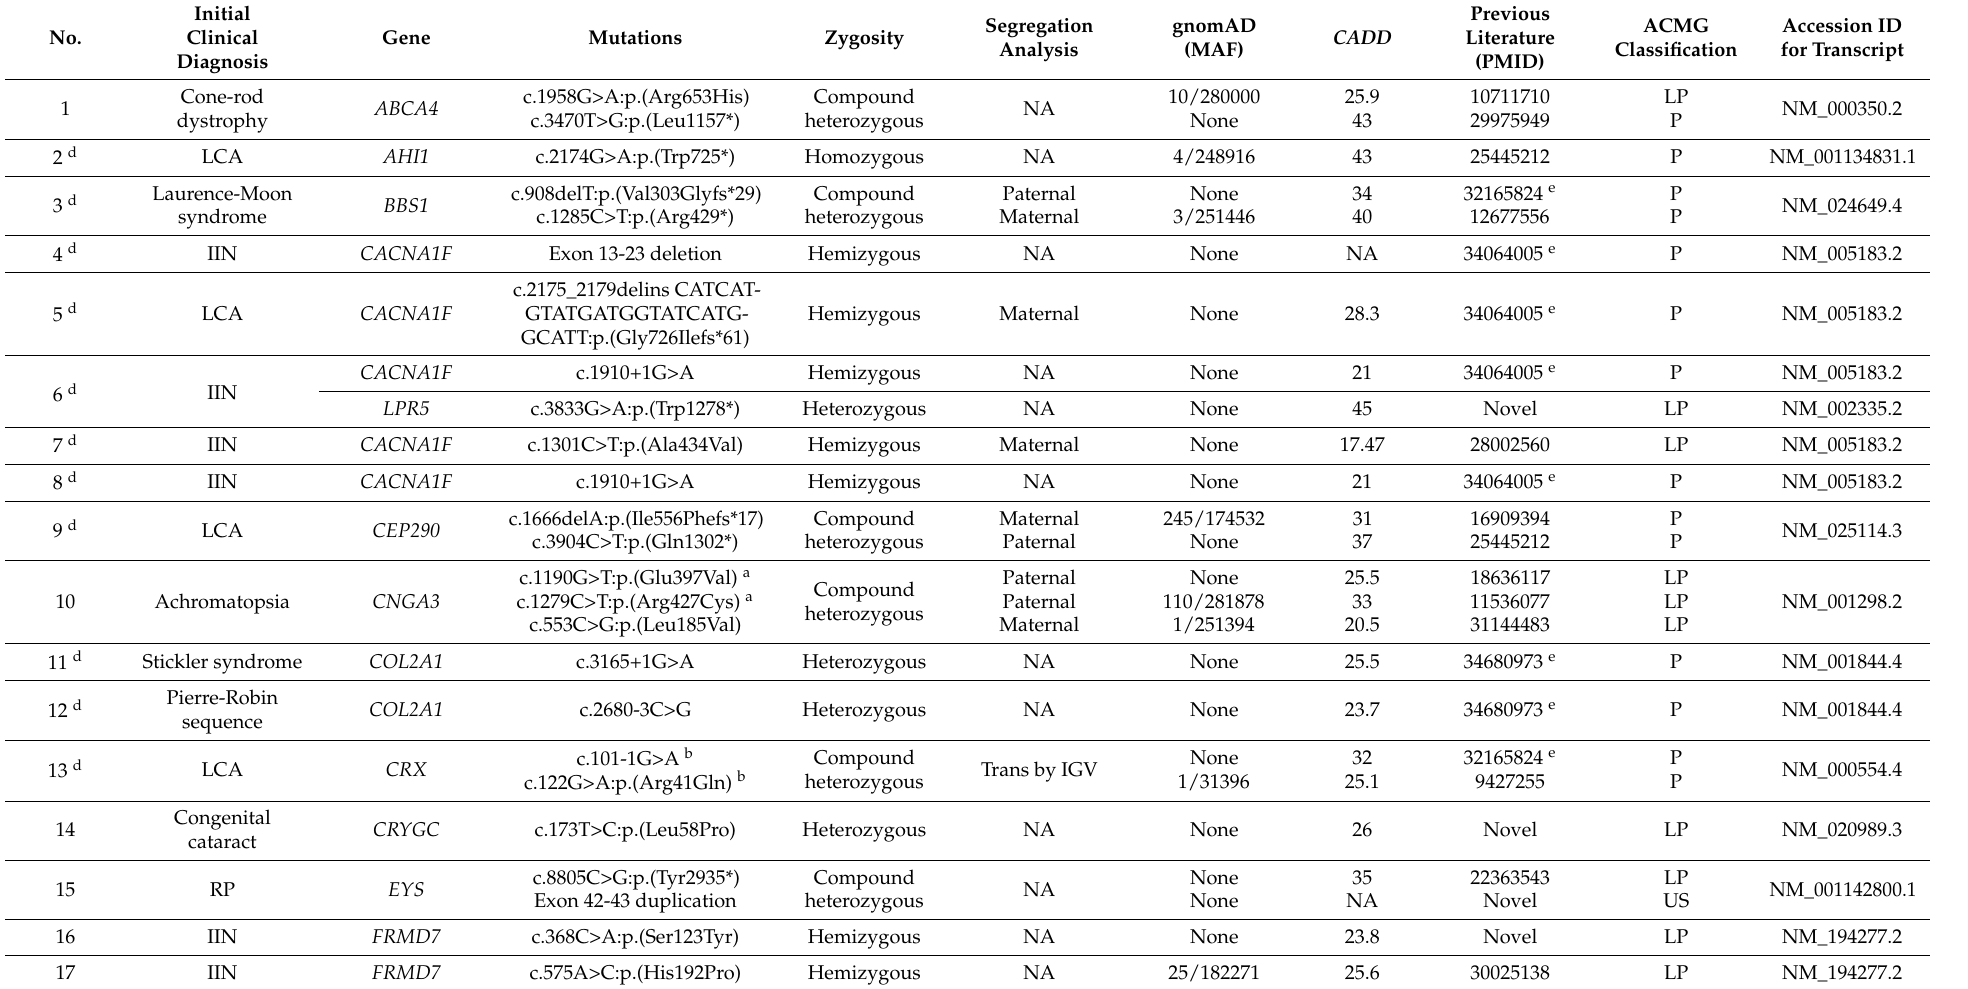
Table 1. Disease-associated variants identified in 86 patients with definite